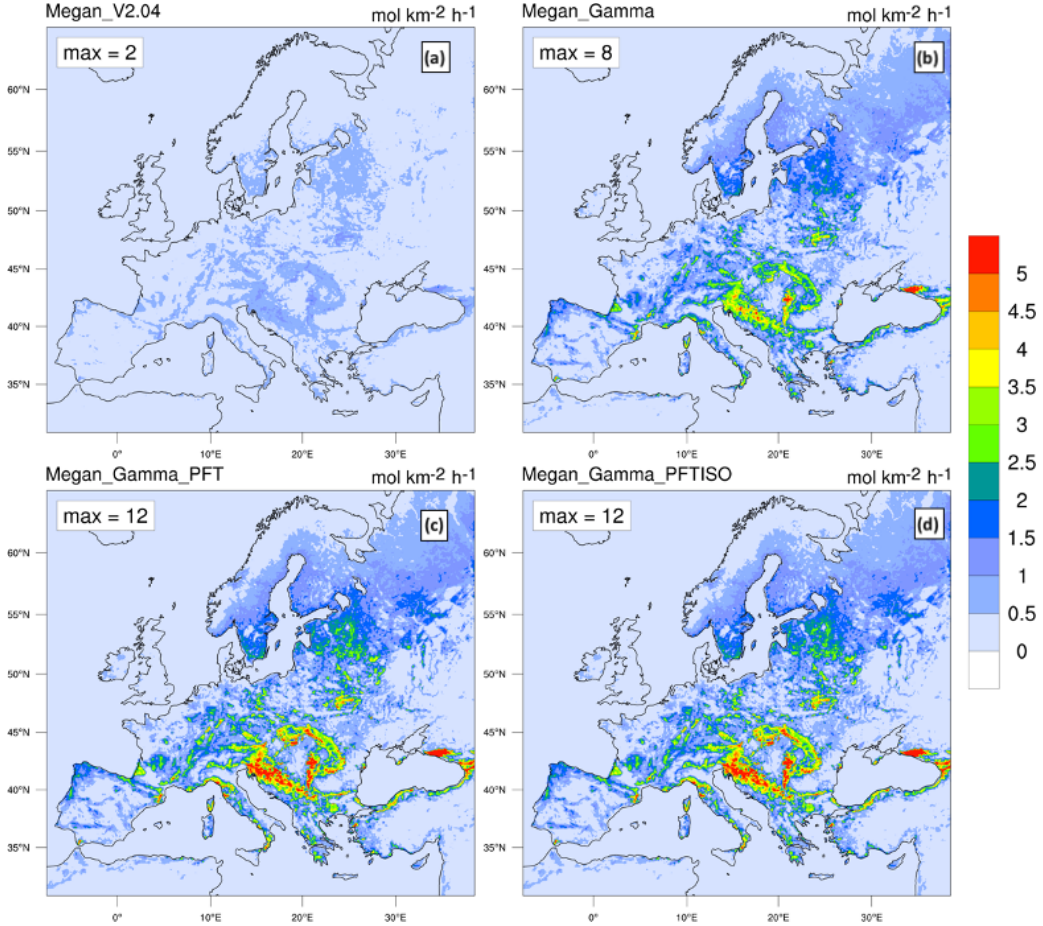
Figure 12. The spatial distribution of α -pinene emissions (molkm − 2 h − 1 ) calculated as a weekly average (from 10 August 2015 at 00:00UTC to 16 August 2015 at 00:00UTC) for the different MEGAN configurations, namely (a) the control simulation (M2.04), (b) activity